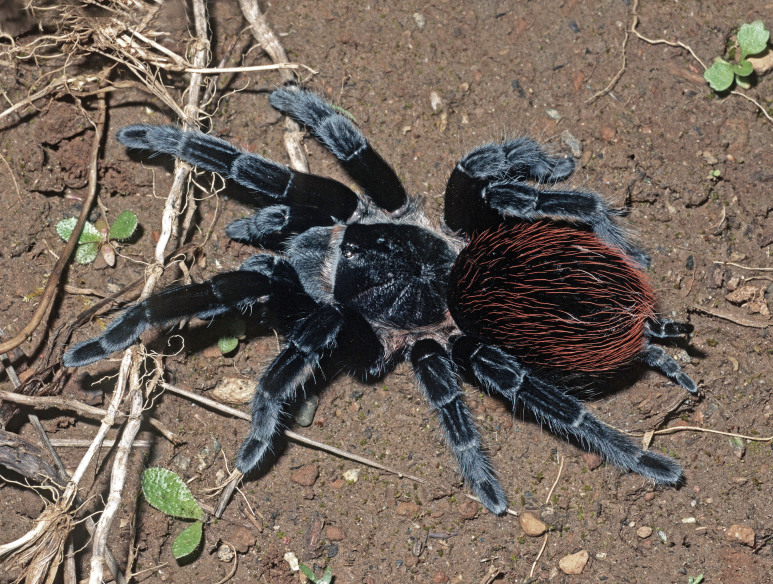
Brachypelma
vagans (Ausserer, 1875) female from Orange Walk district, Belize. Photo: Rick C. West.